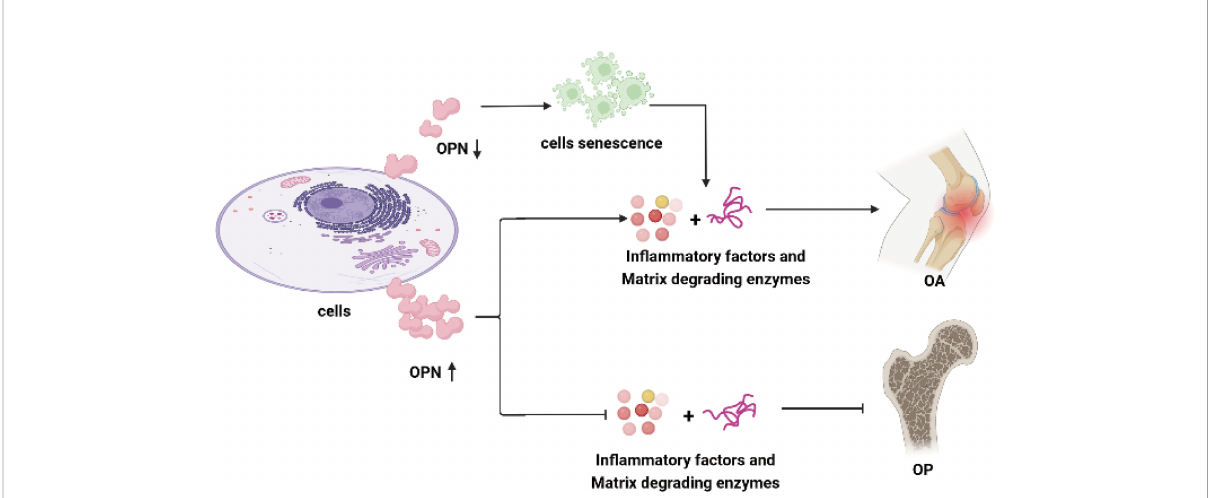
FIGURE 1 OPN regulates in fl ammatory activity in OA and OP. OPN plays a controversial role in the in fl ammation response in OA. Overexpression of OPN in chondrocytes, synoviocytes and subchondral bone stimulates the secretion of proin fl ammation cytokines and enhances the in fl ammation activity in OA. OPN-de fi ciency in chondrocytes leads to chondrocyte senescence and the secretion of cytokines and proteins degraded the articular cartilage. A high level of OPN suppresses the secretion of proin fl ammation cytokines and matrix-degrading enzymes, alleviates bone mass reduction, and promotes bone formation as well as matrix calci fi cation in OP. The proin fl ammation cytokines include IL-1 b , TNF- ɑ , IL-6, IL-8, NO, iNOS, COX-2, and CRP, while the articular cartilage matrix-degrading enzymes mainly refer to MMP-9, MMP-13, ADAMTS-4, ADAMTS-5 in this